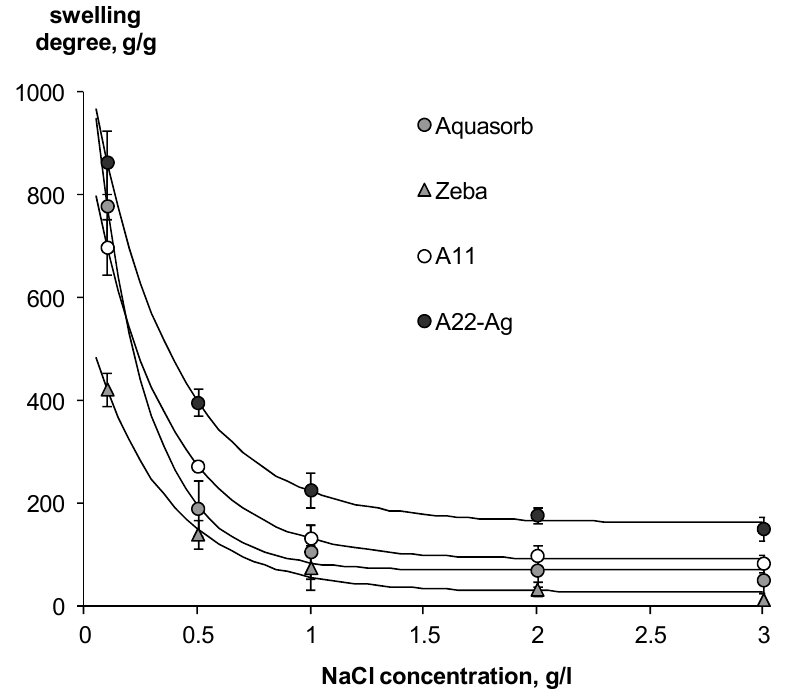
Figure 4. Swelling of gel-forming soil conditioners in sodium chloride solutions.